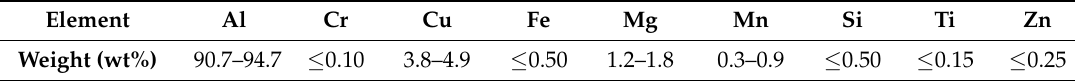
Table 1. Typical nominal chemical composition of AA2024-T351